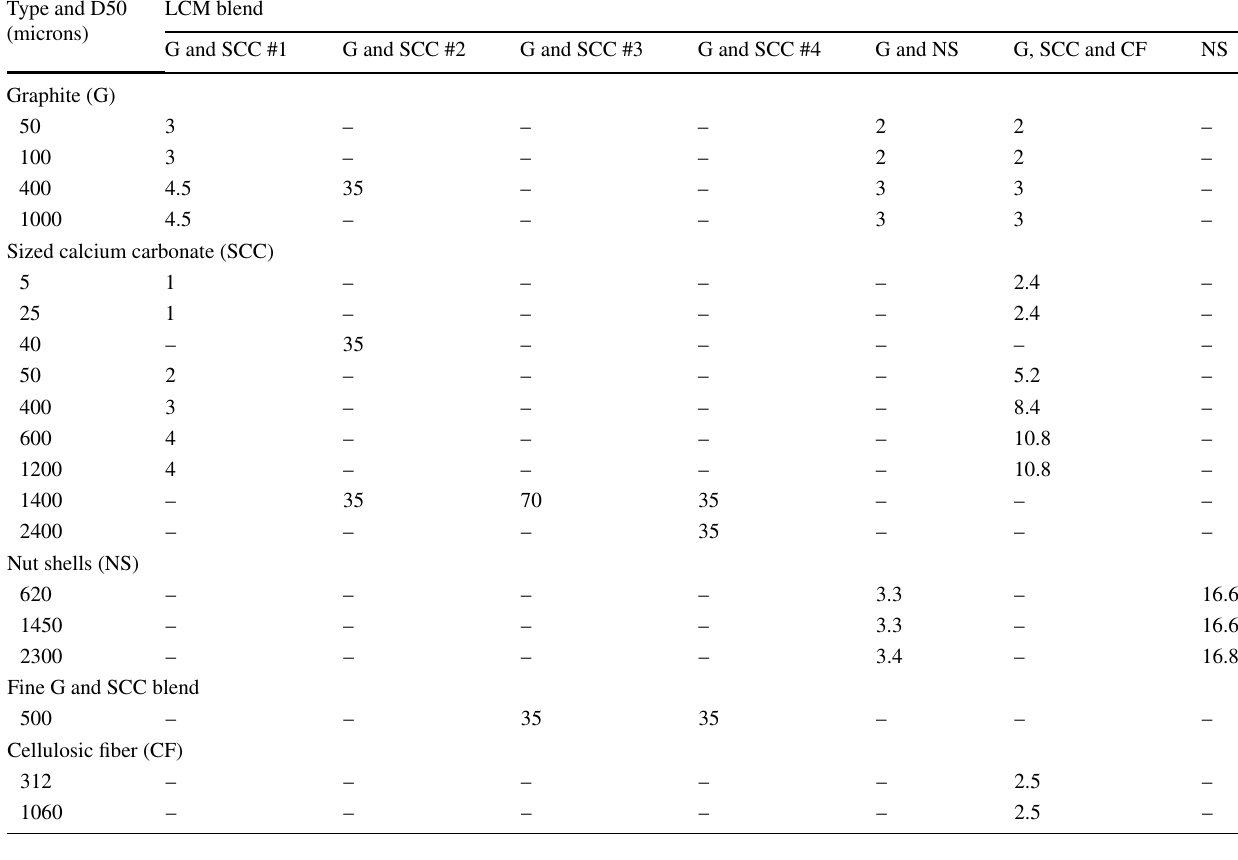
Table 2 LCM treatment formulations